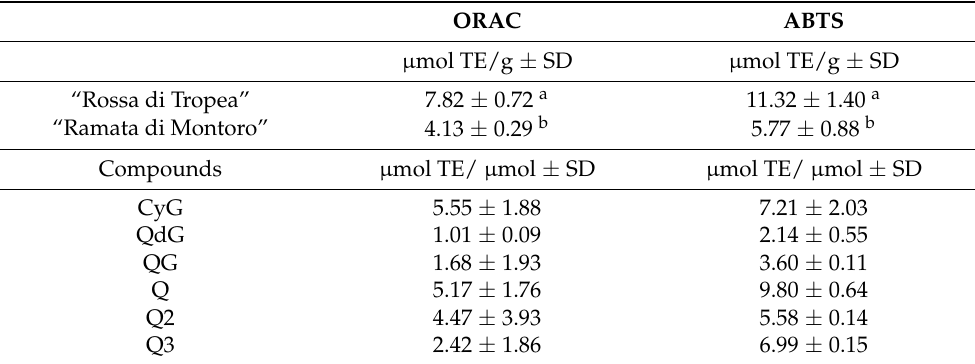
Table 3. Antioxidant Activity of “Rossa di Tropea” and “Ramata di Montoro” onion skin extracts and main